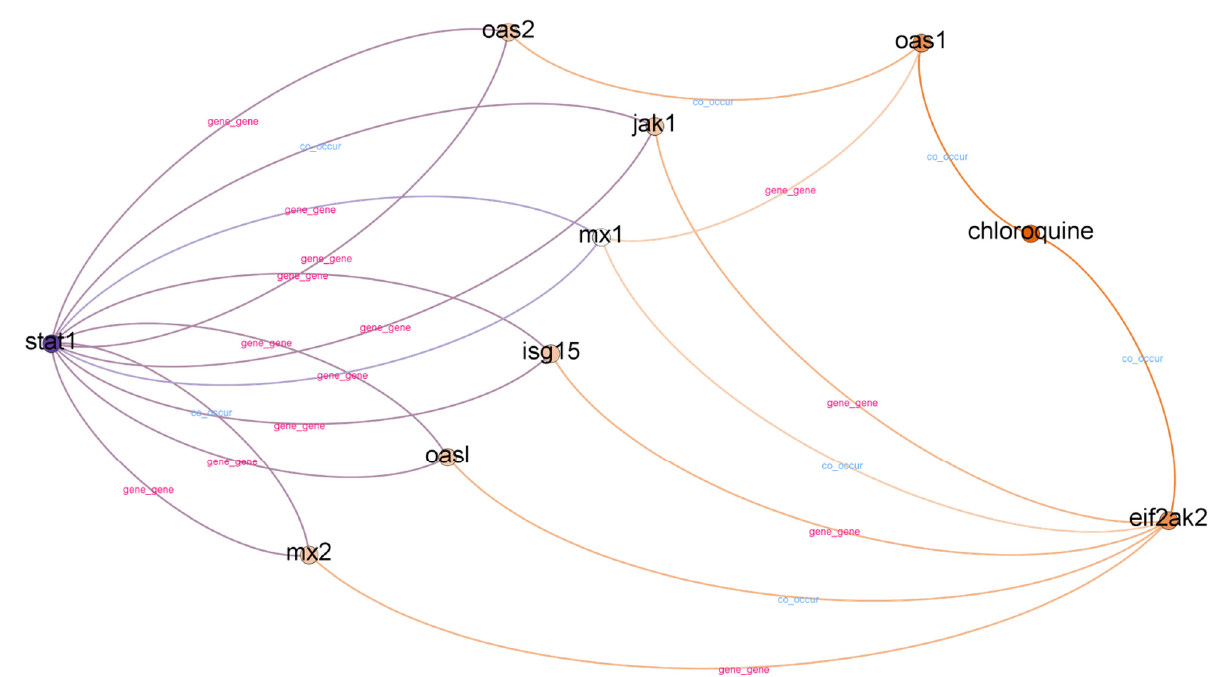
Figure 4. Subgraph from top-ranked paths with a depth of three in STAT1 and chloroquine